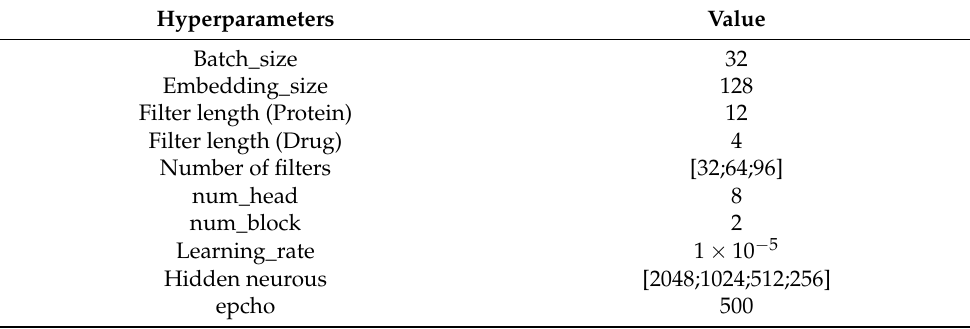
Table 1. Hyperparameter optimization and their tuned values.